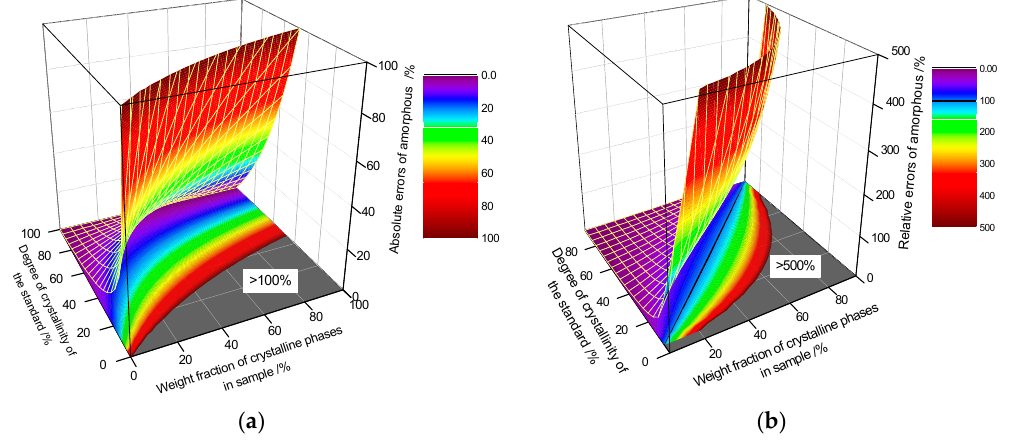
Figure 2. Error analysis between the original and improved equation ( a : the absolute error ( Δ AE ); b : the relative error ( Δ RE )) .